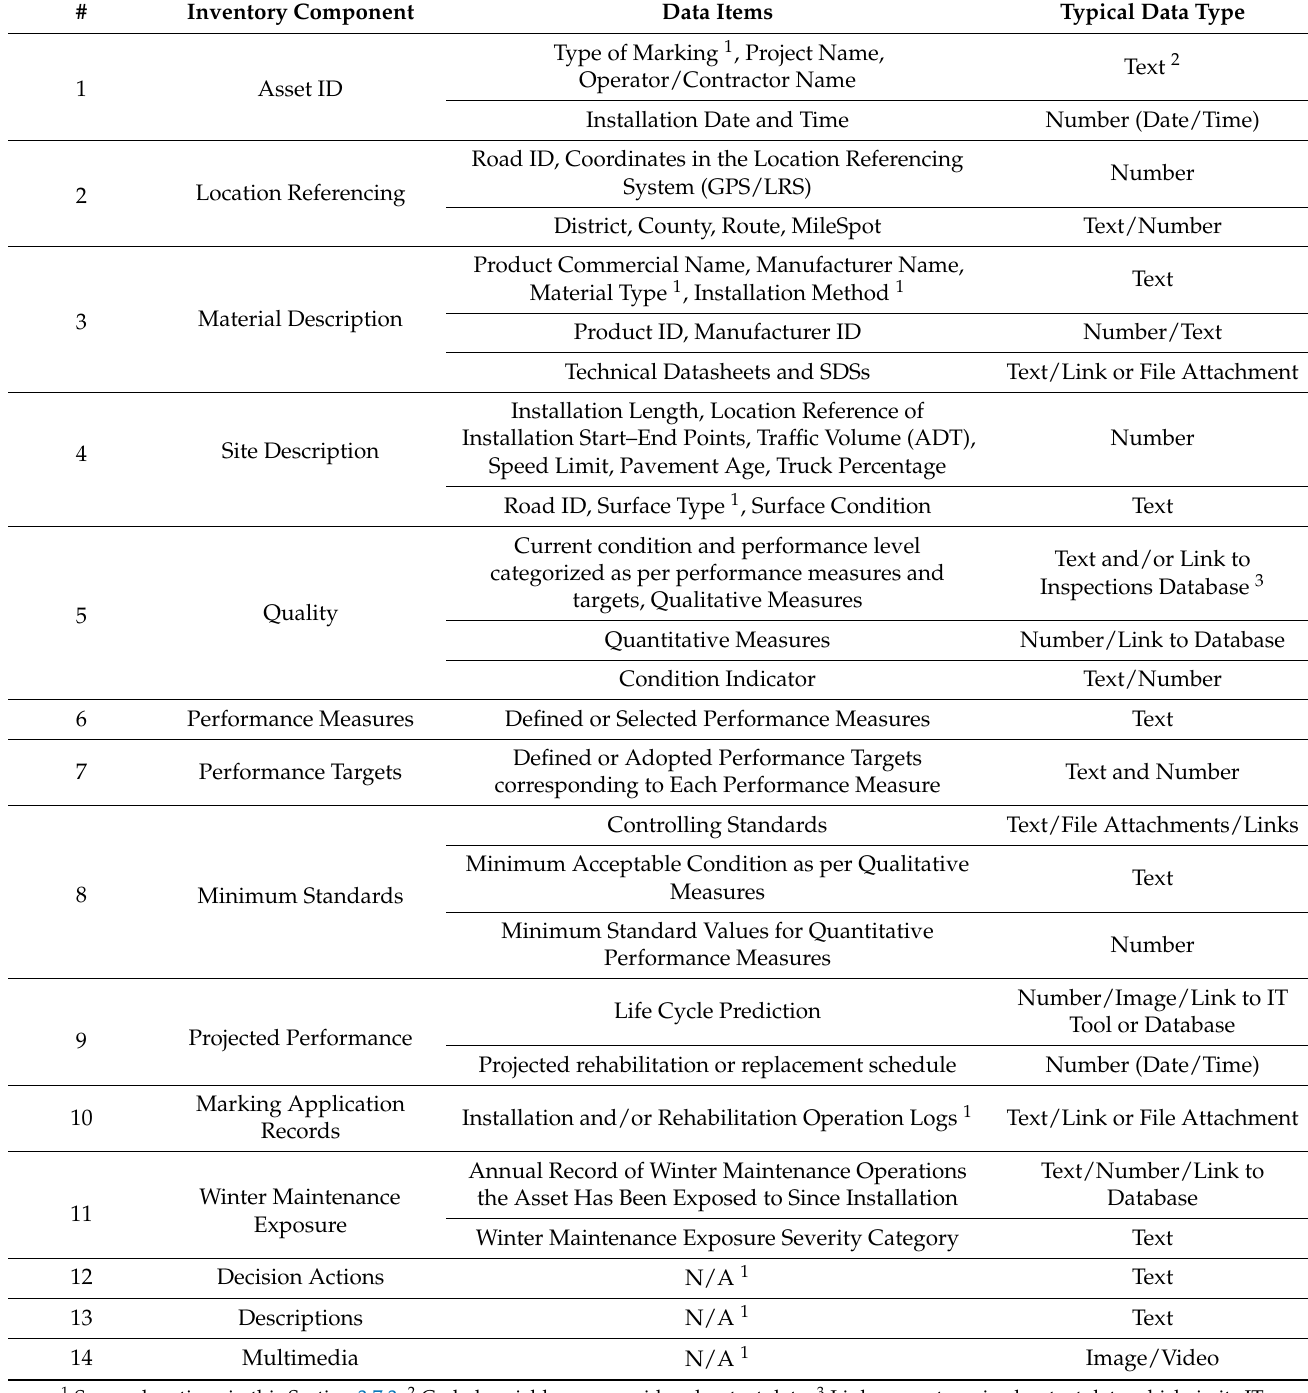
Table 4. Components of the recommended pavement marking